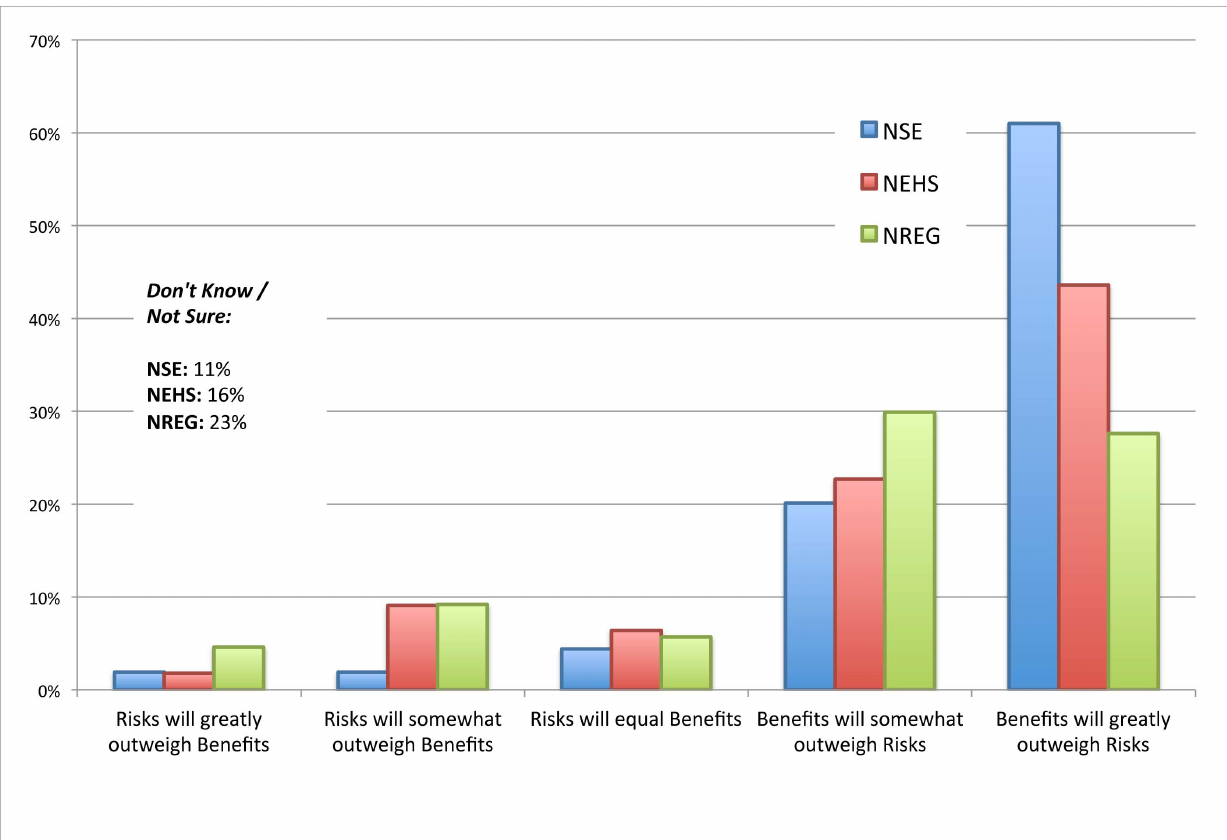
Figure 1. ‘‘Risk versus Benefit’’ ratings for nanotechnologies in general. Color-coded bars indicate the proportion of respondents in each expert group (NSE, NEHS, and NREG) choosing the indicated response.